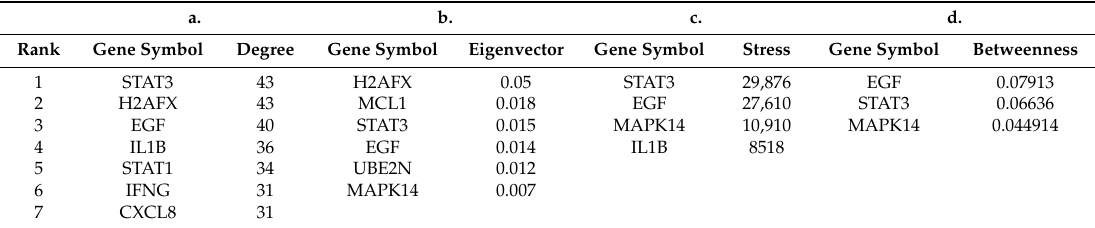
Table 3. Top communicative genes (module 2) ranked based on a. degree, b. eigenvector, c. stress, d. betweenness. a. b. c.